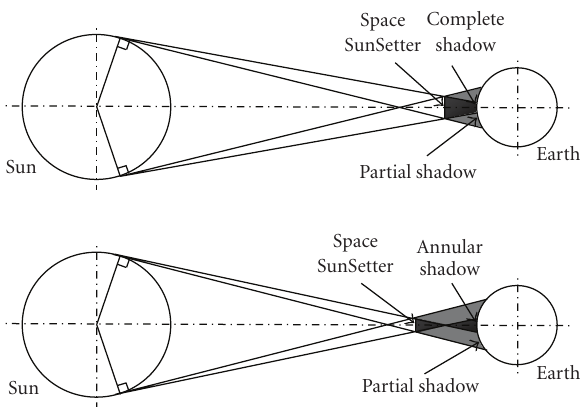
Figure 1: The general geometry for complete, annular, and partial shadow on the Earth’s surface occurred by Space SunSetter. The figure is greatly exaggerated to illustrate the idea.